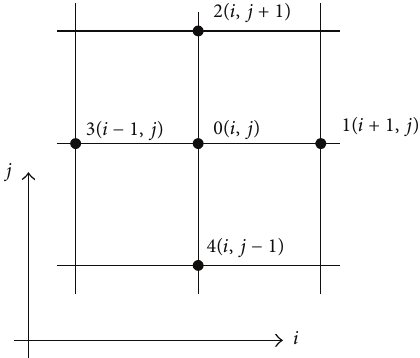
Figure 2: One node cell of square network